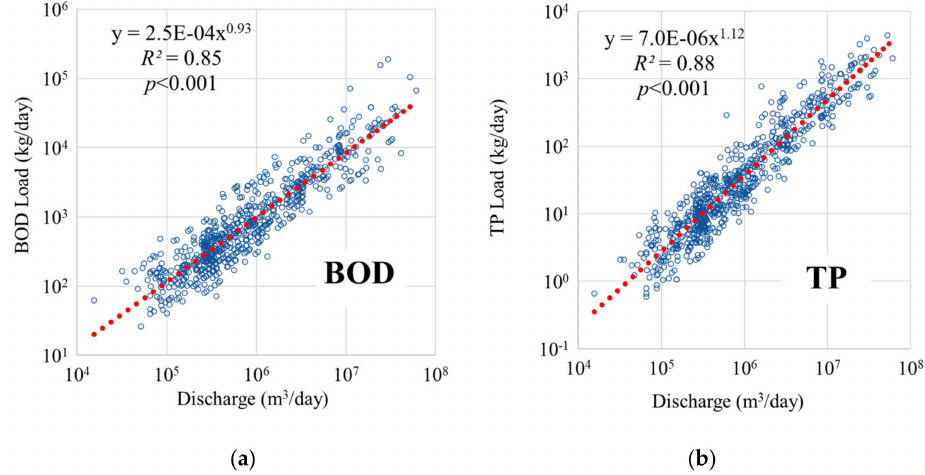
Figure 7. Relationship between flow rate and pollution load: ( a ) BOD; ( b )